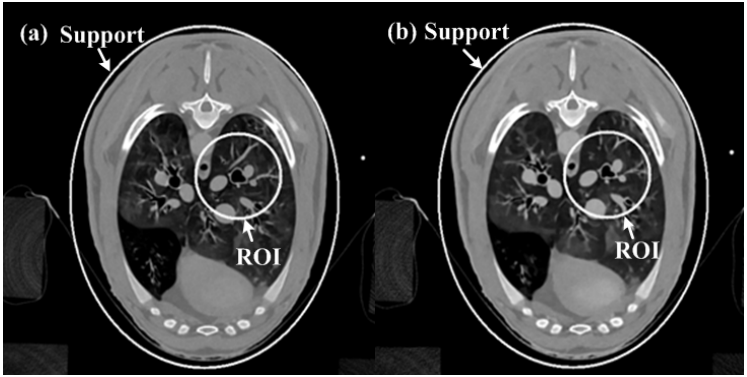
Figure 4. Reconstructed images from real CT projection data: ( a ) Normal dose; ( b ) low dose. The display window is [ − 700 800]HU.